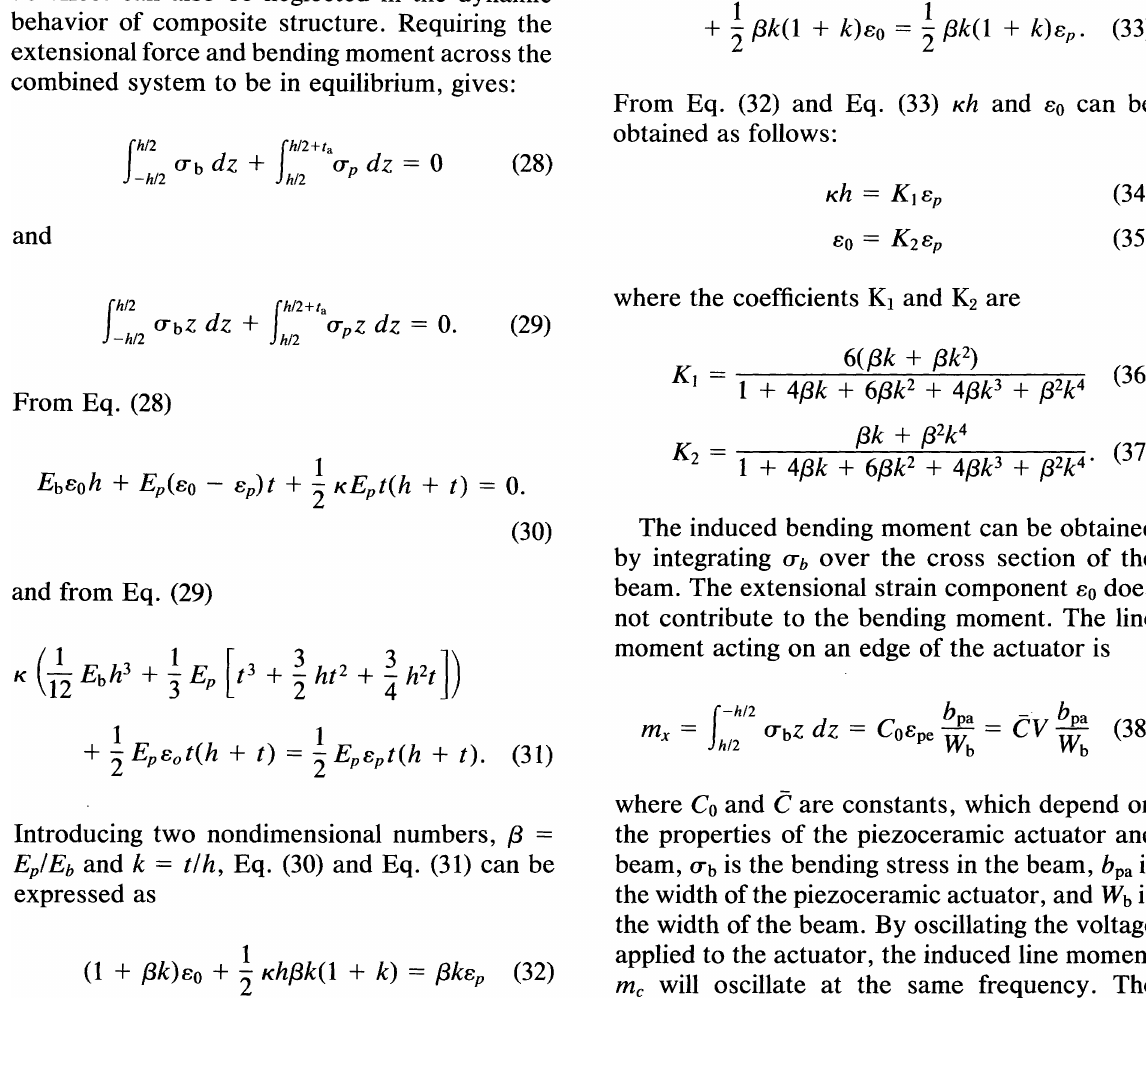
FIGURE 5 Stress distribution in beam-distributed actuator